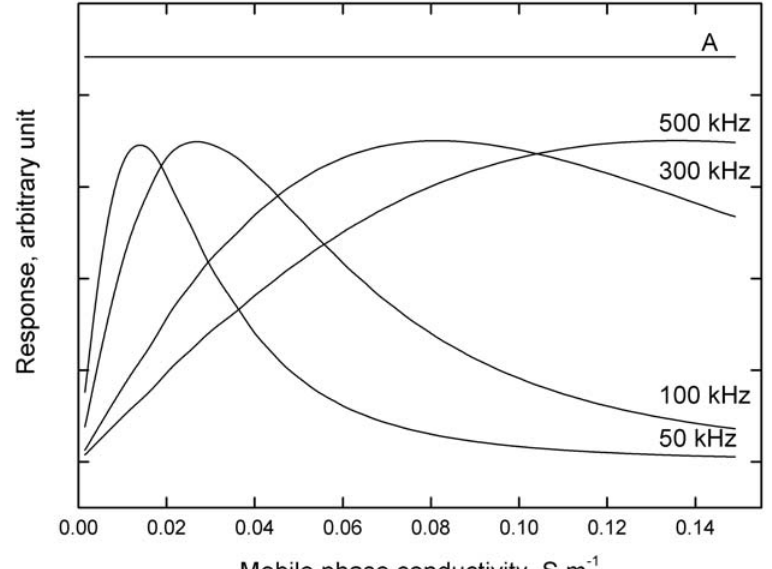
Figure 7. Model dependence of the detector response to a sample with constant conductivity introduced into carrier solutions with various conductivities, at various input voltage frequencies. For comparison, the response produced by cell with purely ohmic resistance is given by straight line A. The modeling parameters are: carrier liquid , in a range from 1.5 × 10 − 3 to 1.5 × 10 − 1 S m − 1 (corresponding to ca. 10 − 4 conductance, κ E = 1.5 × 10 − 4 S m − 1 (corresponding to ca. 10 − 5 to 10 − 2 M KCl); analyte conductance, and κ A + κ , w = 2 mm; for the other parameters, see M KCl); the detected conductance equals κ E A Figure